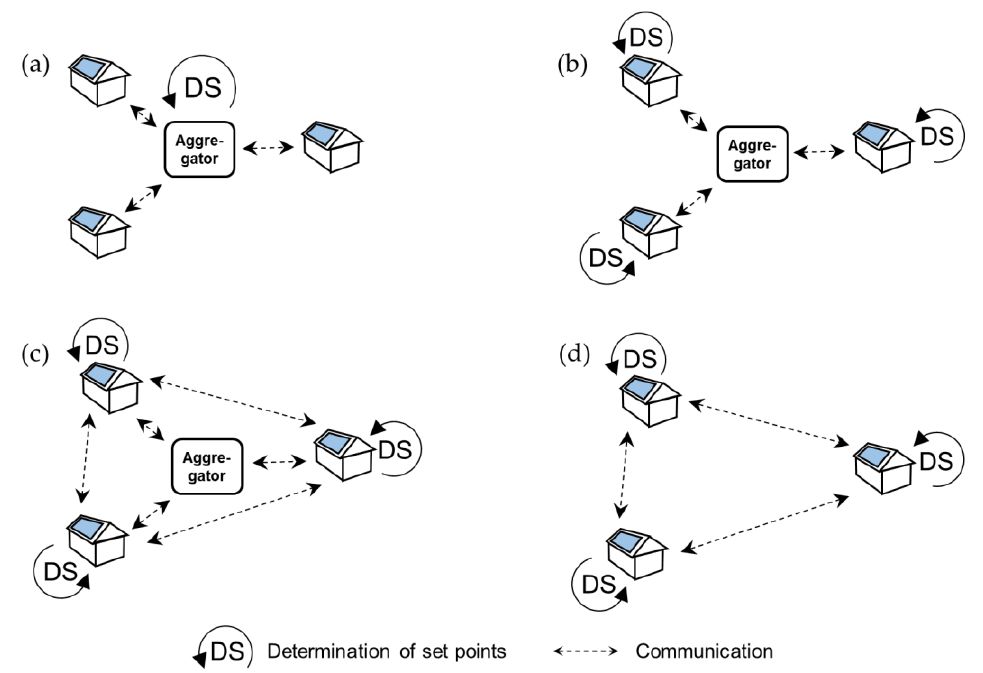
Figure 2. Superordinate energy management (EM) structures: ( a ) centralized; ( b ) decentralized fully-dependent; ( c ) decentralized partially-independent; ( d ) decentralized fully-independent (adapted from [13]).